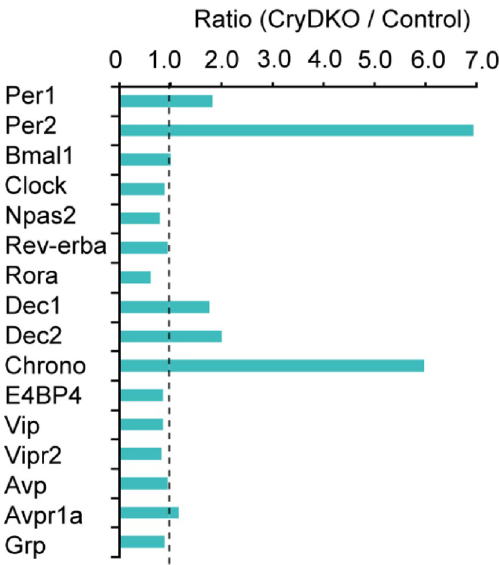
Figure 1. Expression of representative genes in neonatal Cry1/Cry2 deficient and control SCN. Relative gene expression in Cry1/Cry2 deficient mice to that in the control is illustrated as a bar graph. Gene expression in Cry1/Cry2 -deficient SCN was divided by that in the control SCN (Ratio). Clock genes, several clock related genes, SCN related major neuroendocrine genes, and their receptor genes are demonstrated in the